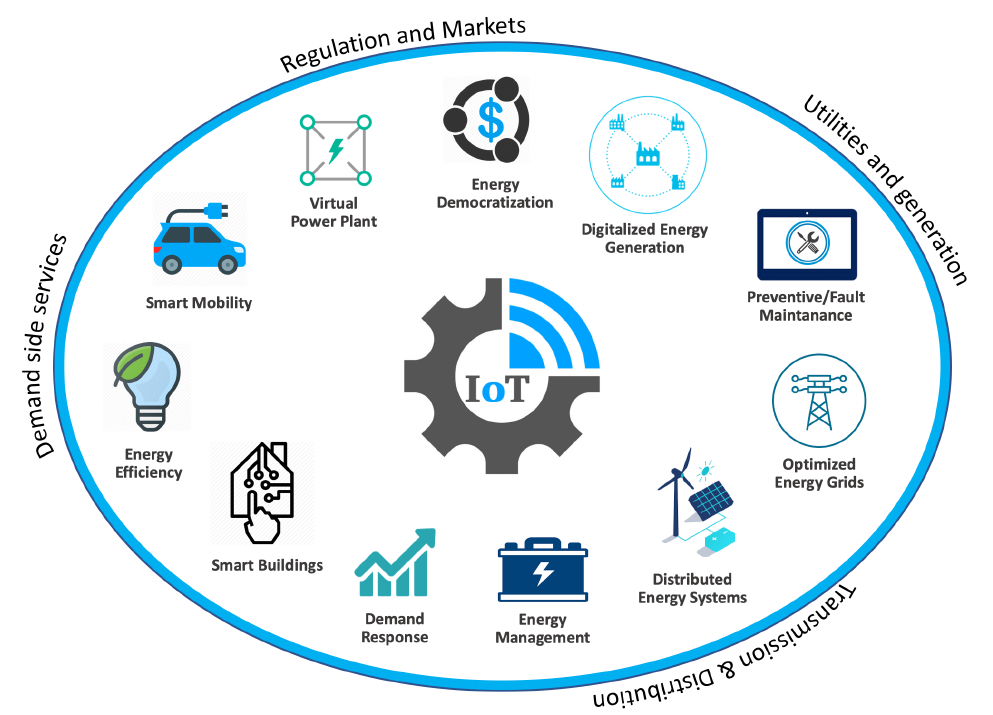
Figure 5. Applications of IoT in an integrated smart energy